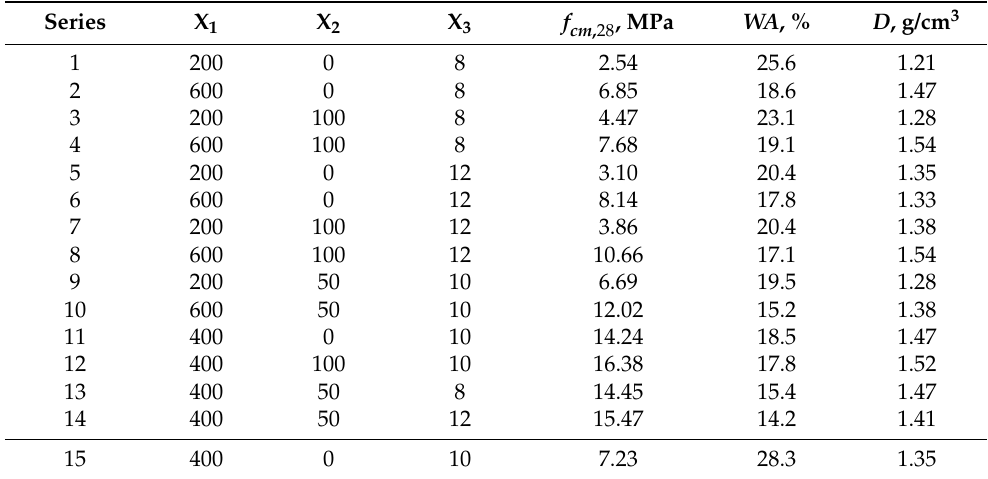
Table 8. The average test results for compressive strength after 28 days, water absorption and the apparent density of the GLC.